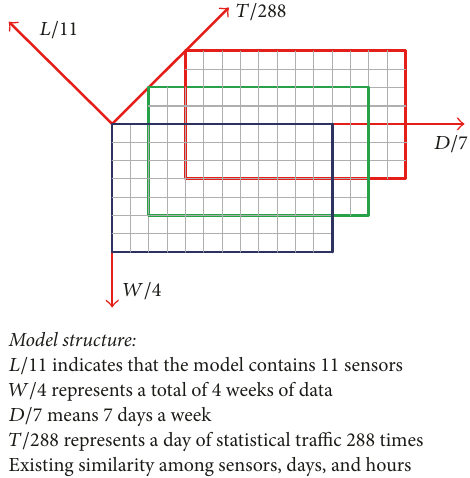
Model structure: L/11 indicates that the model contains 11 sensors W/4 represents a total of 4 weeks of data D/7 means 7 days a week T/288 represents a day of statistical traffic 288 times Existing similarity among sensors, days, and hours Figure 5: Tensor model of traffic